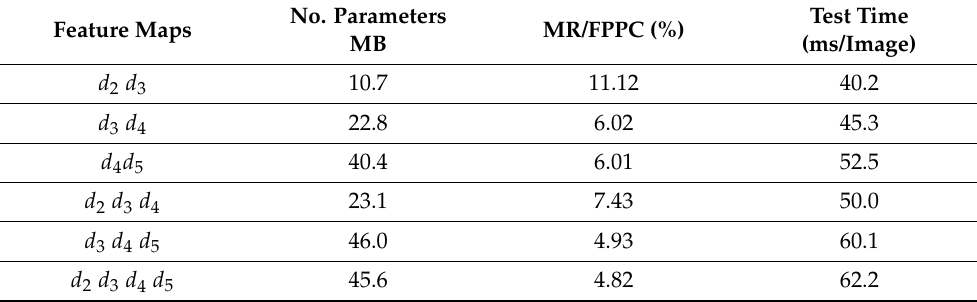
Table 4. Performance of various feature map concatenations for multi-scale purposes.